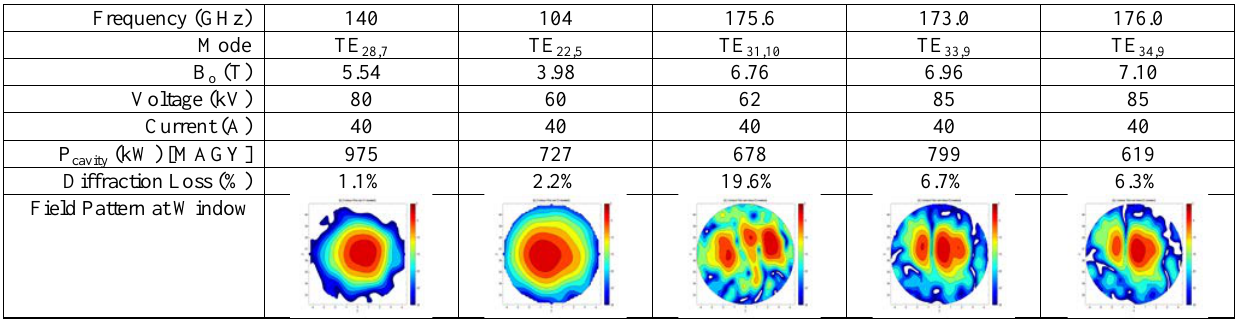
Table 2. Simulated performance of the VGT-8141A gun, cavity, and internal